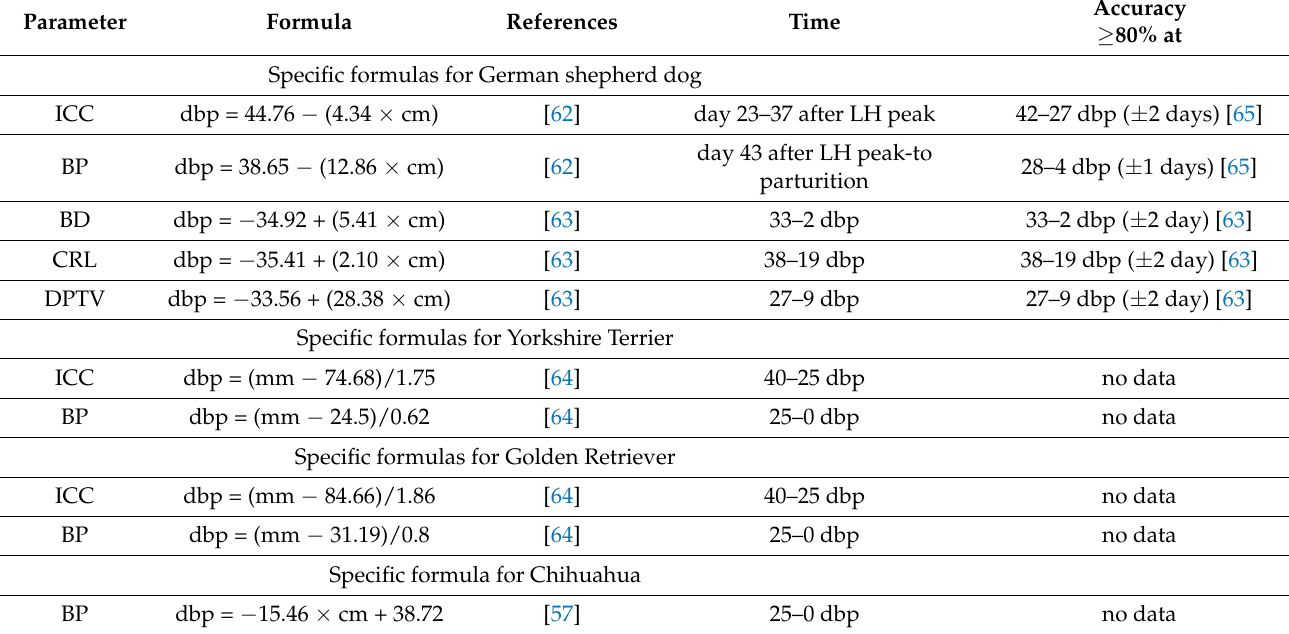
Table 5. Specific formulas for calculations of days before parturition (dbp) in different breeds (German Shepherd, Yorkshire Terrier, Golden Retriever and Chihuahua) for inner chorionic cavity (ICC), crown-rump length (CRL), body diameter (BD), biparietal diameter (BP), deep portion of diencephalo-telencephalic vesicle (DPTV). Using these formulas, dbp could be calculated. The measurements (scale either in mm or cm) are the mean of ICC and BD orthogonal measurements in all measured fetuses, respectively. References are reported in brackets. Time of measurement refers to the dbp or days after LH peak in which each parameter was calculated. When available, dbp in which accuracy was ≥ 80% ( ± 1 or ± 2 days) is also